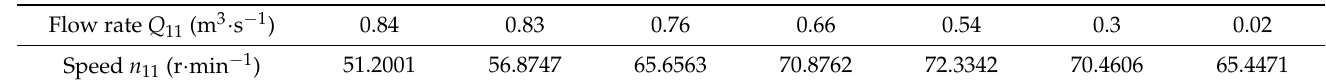
Table 3. Flow-speed test data.